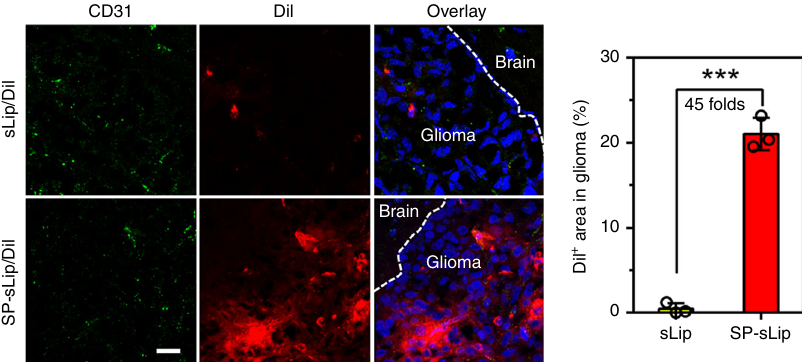
Fig. 5 Biodistribution of sLip and SP-sLip in intracranial glioma. DiI-labeled sLip (sLip/DiI) and SP-sLip (SP-sLip/DiI) were injected via tail vein of nude mice bearing intracranial glioma (at day 16 after implantation). Mouse brains were dissected and sectioned at 4 h after administration. Brain slices were stained with anti-CD31 antibody (green) and biodistribution of liposomes (red) in normal brain tissues (labeled with Brain) and glioma region (labeled with Glioma) were observed by confocal laser scanning microscopy and quanti fi ed by Image Pro. Scale bar = 20 μ m. Data are means ± SD ( n = 3). *** p < 0.001 by student ’ s t plasma protein absorption on liposomal surface is inevitable even in the presence of PEG 8,48,49 . Modi fi cation of targeting ligands on the distal end of PEG is widely used to functionalize liposomal surface, which would severely affect the formation of protein